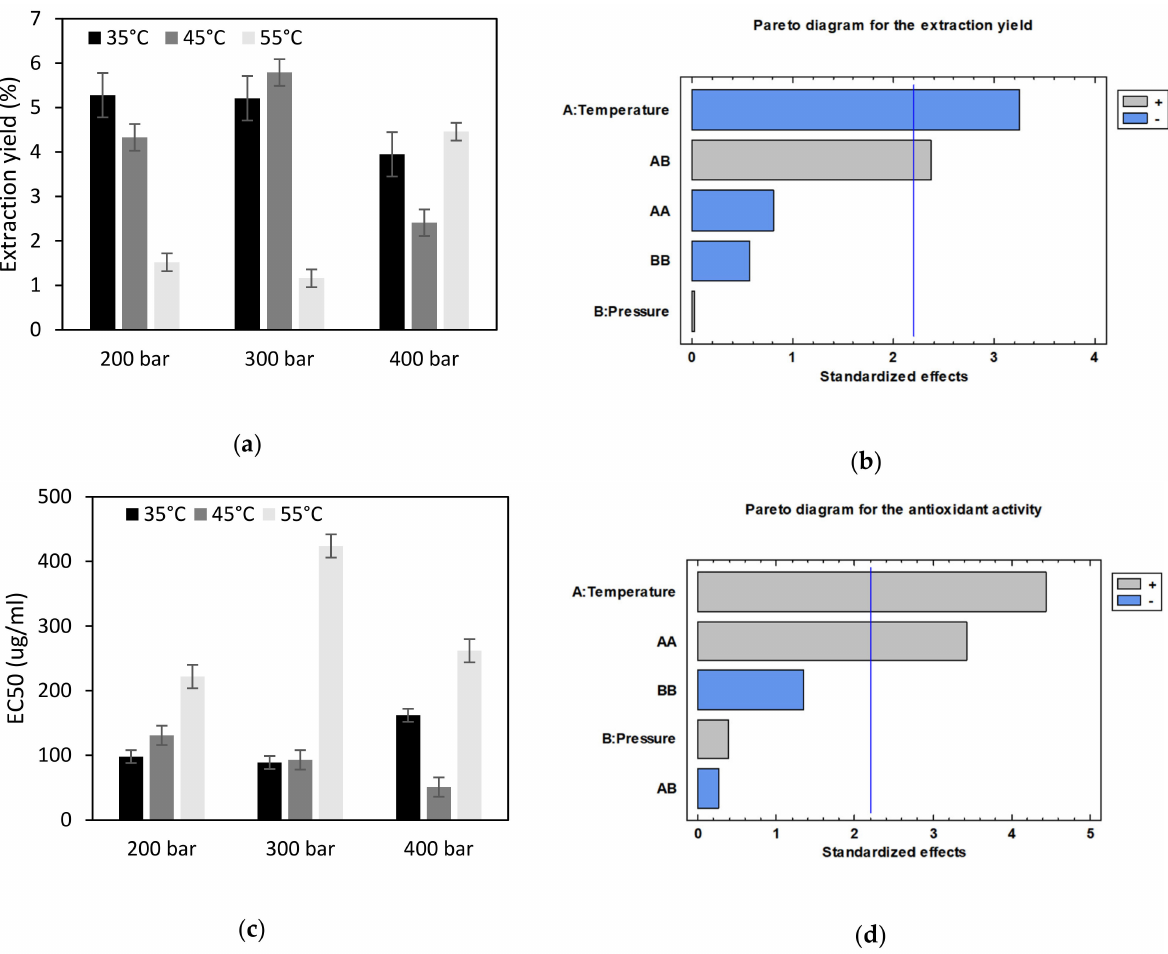
Figure 3. Extraction yield ( a ), Pareto diagram of the extraction yields ( b ), antioxidant activity ( c ), and Pareto diagram of the antioxidant activity ( d ) of the extracts obtained from orange peels using CO 2 + 16% ethanol ( p =